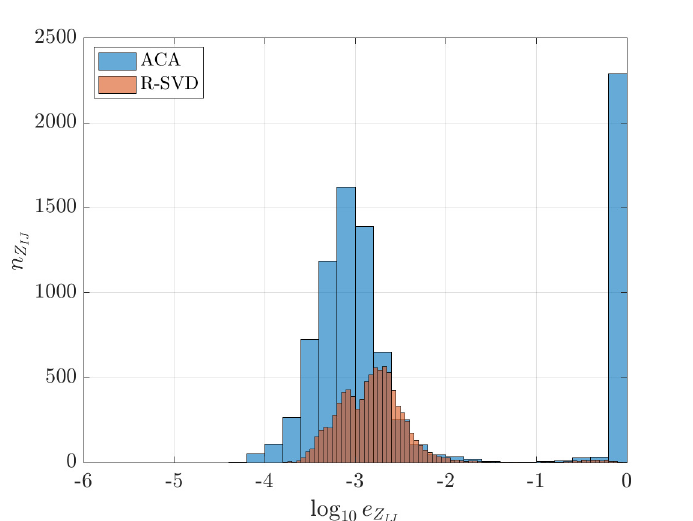
Figure 10. Compression error distribution for the double-layer matrix computed by ACA and R-SVD algorithms: percentage compression error e Z algorithms is 10 − 3 , which corresponds to − 3 in abscissa.